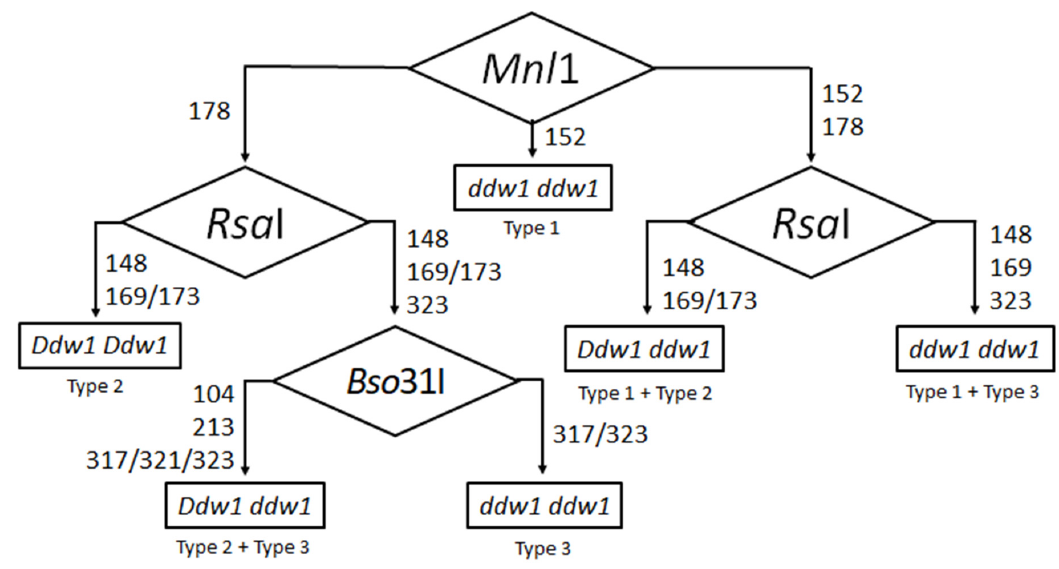
Figure 4. REMS1218 CAPS analysis for Ddw1 genotyping of rye and triticale. Diamonds in the flowchart denote the digestion of the original REMS1218 PCR product by a restriction endonuclease; numbers indicate the sizes of the fragments after the digestion in accordance with the rough estimate in Figure 3. In the case of plants that carry Type 1 ddw1 allele, restriction analysis by Mnl 1 followed by Rsa I distinguishes Ddw1 , ddw1 homozygotes and Ddw1 ddw1 heterozygotes. If the analysis reveals a single product after Mnl 1 digestion and three products after Rsa I digestion, then Type 3 ddw1 allele is homozygote and Ddw1 ddw1